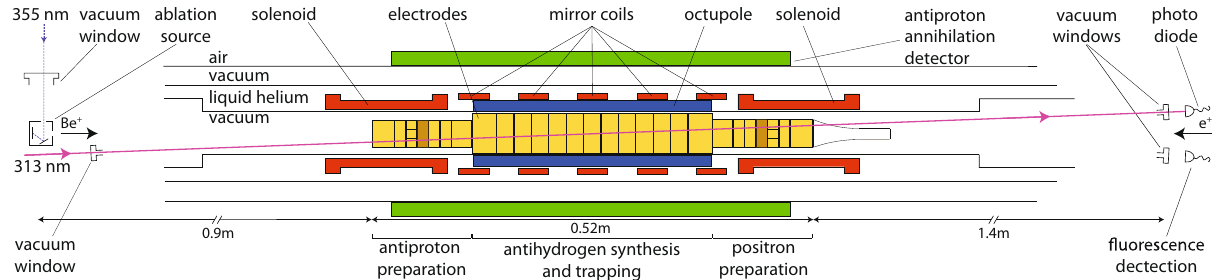
Fig. 1 ALPHA trap setup with Be + source and cooling laser. The main solenoid supplying a 1 T axial fi eld throughout the center is not shown. The cylindrical electrodes (yellow/orange) can be individually charged to provide the axial electric fi elds for con fi nement. The central part is to scale. The short solenoids on either end can increase the axial fi eld to 3 T in those regions. In typical operating conditions the fi eld strength is homogenous to 1 part in 10 4 across a cylindrical region of ø6 mm × 60 mm in the center 40 . The positron source and MCP/Phosphor assembly are to the right of the fi gure but not